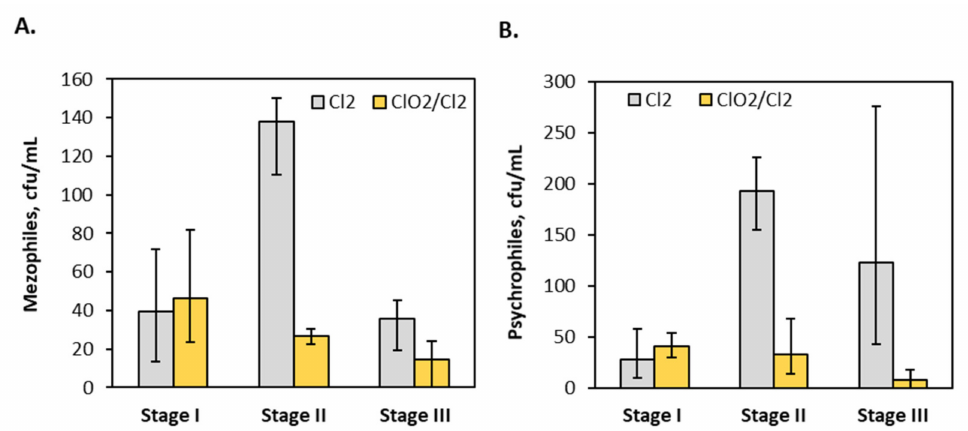
Figure 4. The influence of chlorine dioxide on the microbiological parameters of swimming pool water: ( A ) mesophiles; ( B )